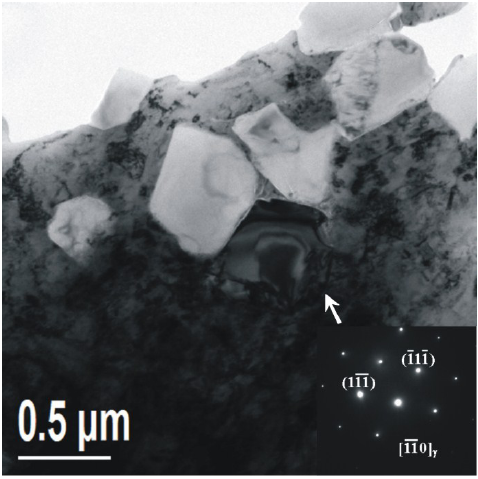
Figure 7. TEM and corresponding diffraction patterns of the austenite in the base